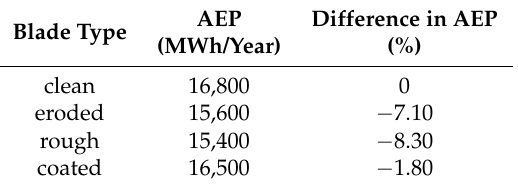
Table 6. Comparison of the annual energy production (AEP) using different